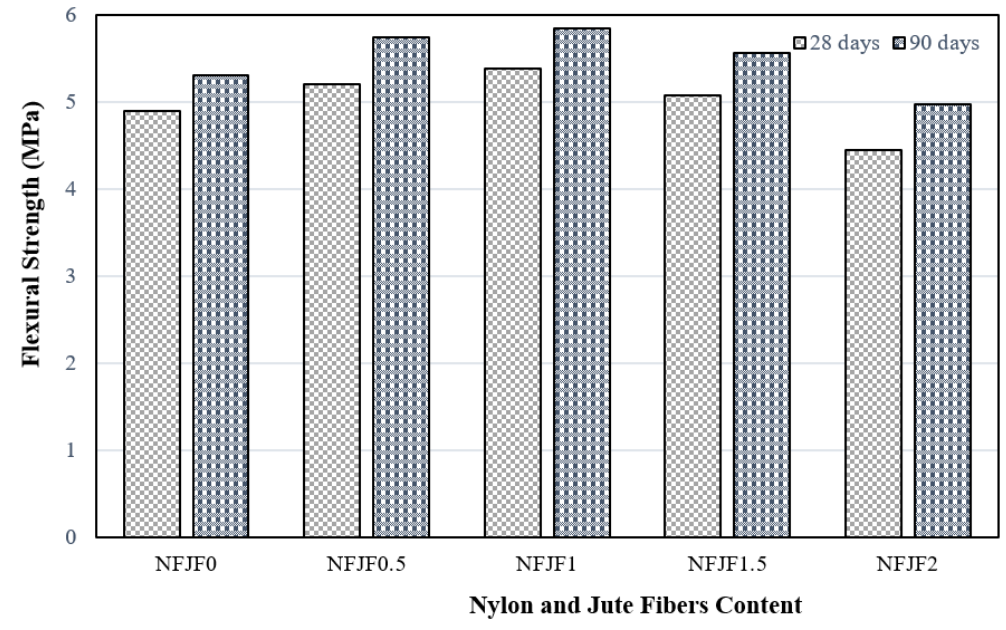
Figure 9. Flexural strength of concrete.